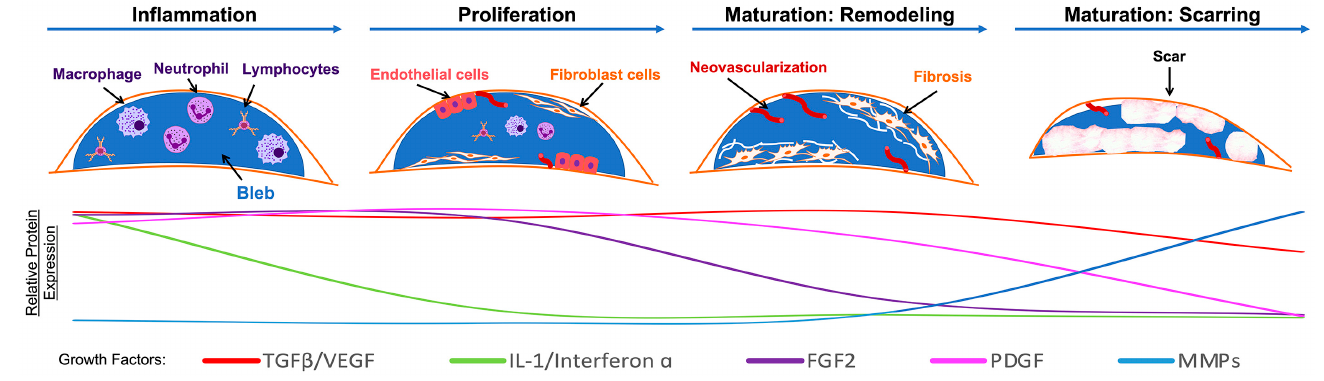
Figure 1. Stages of wound healing and key markers following glaucoma filtration